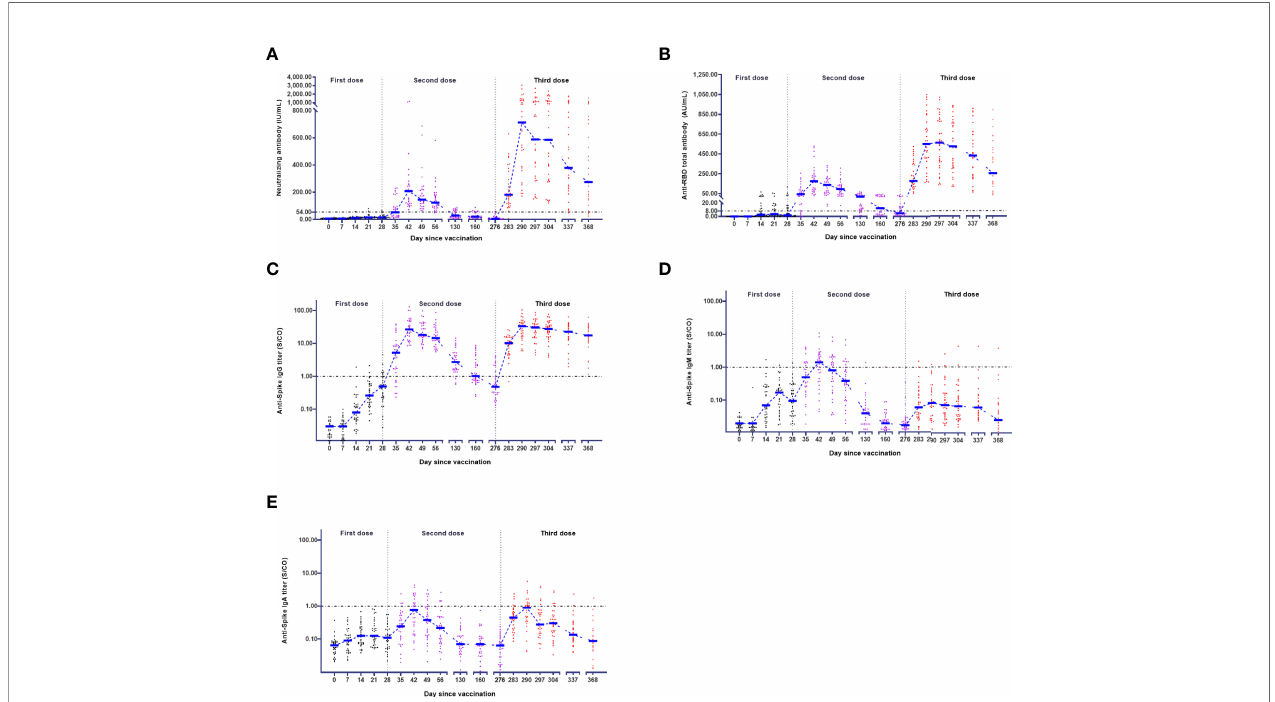
FIGURE 1 | Kinetics of antibodies in the vaccination schedule. The levels of neutralizing antibody (A) , anti-RBD total antibody (B) , anti-Spike IgG (C) , anti-Spike IgM (D) , and anti-Spike IgA (E) in 32 participants were measured at 18 serial time points over 368 days. The antibody-positive judgement threshold is marked with a